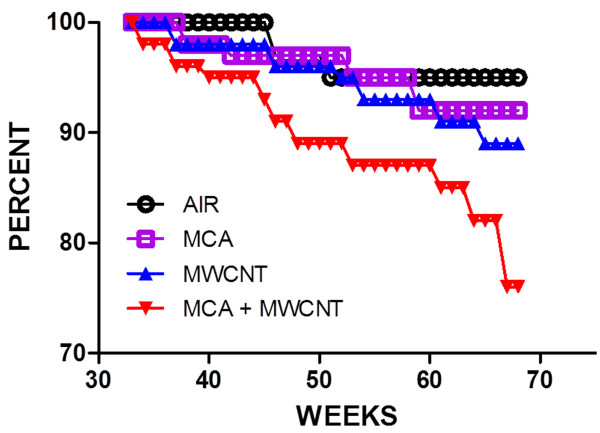
Life table of mice treated with one dose of corn oil (Air), MC (MCA), MWCNT only MWCNT or MCA followed by MWCNT (MC + MWCNT). The life table in Figure 7 shows the percent of mice alive in each treatment group at 30 weeks after exposure to the time of sacrifice 70 weeks after exposure. The MCA + MWCNT treated animals had a greater number of early deaths than the MWCNT, the MCA or the Air treated mice.